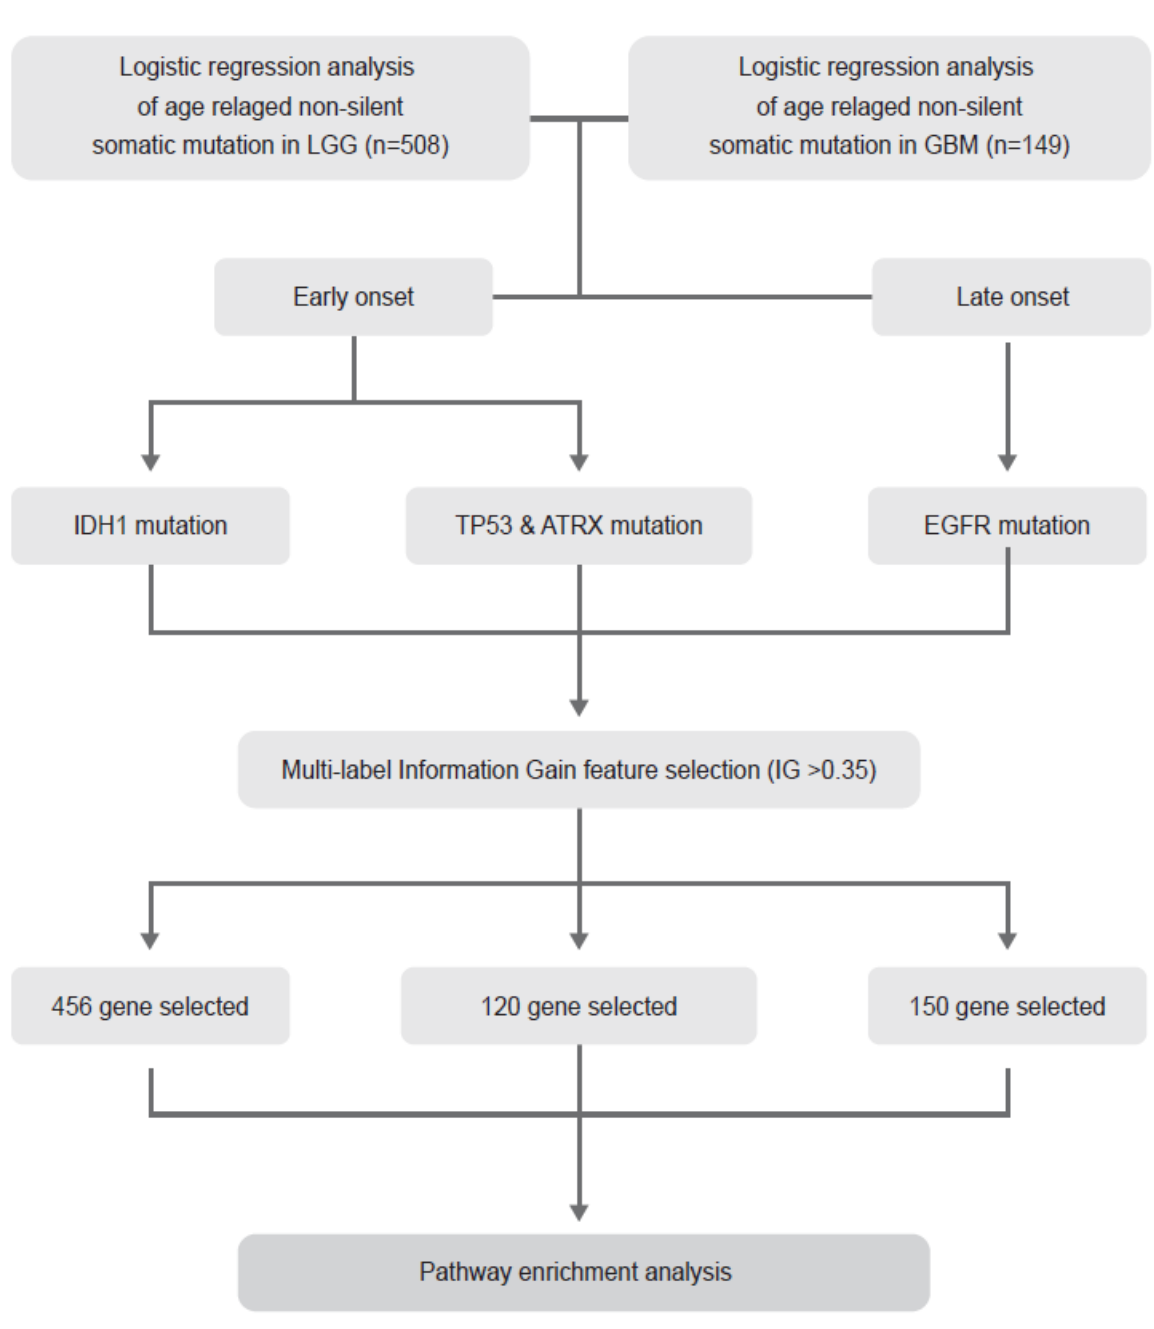
Figure 8. The flow chart of entire process of analysis.